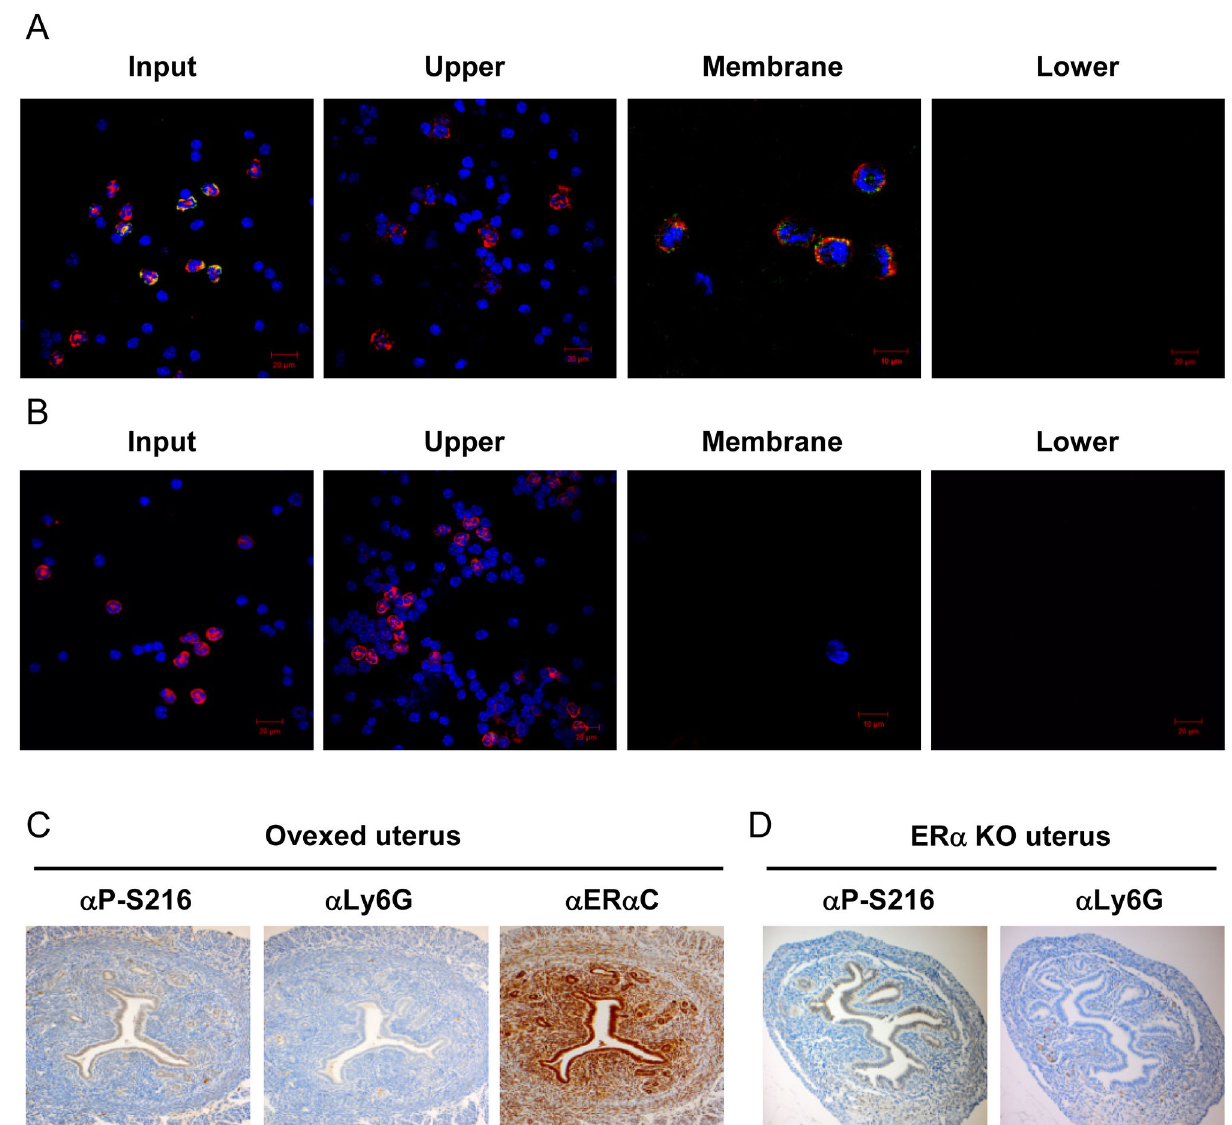
Figure 6. Migration and infiltration of phosphorylated ERα-expressing neutrophils. WBC fractions were prepared from peripheral blood of C3H/HeNCrIBR (A) and ERα KO (B) females and were subjected to migration assays as described in the Experimental section. Cells before migration and cells in upper, lower compartments and the lower surface of the dividing membrane were double stained with anti-Ly6G (αLy6G) and anti-P-Ser-216 (αP-S216) antibodies. Staining was visualized as described in the legend of Figure 2 and images are presented as described in that of Figure 4. (C) Serial sections of the uterus of ovariectomized females were stained by αP-S216, αLy6G or anti-ERαC (αERαC) antibody. (D) Serial sections of the uterus of ERα KO females were stained by αLy6G or αP-S216 antibody. doi: